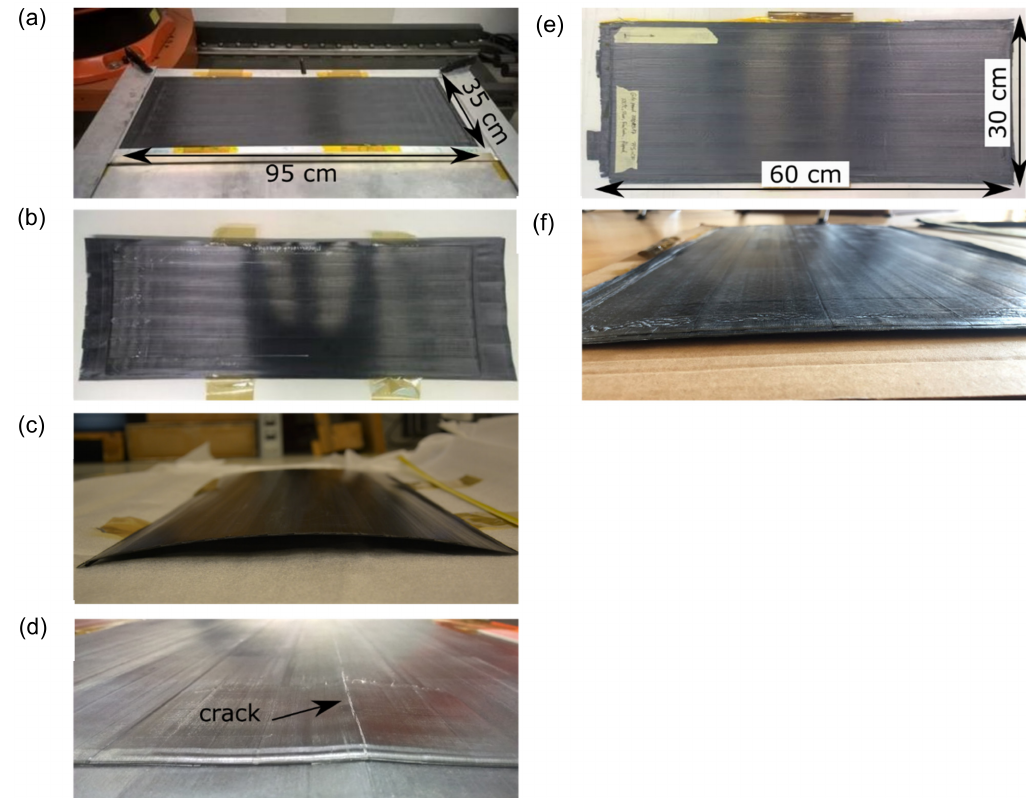
Figure 4. The laminates produced by the clamping method: ( a ) Fixed on the table, ( b ) top, and ( c ) side views after removing the frame, and ( d ) a closer view on the crack due to residual stresses in c-5-330 and the flipping method: ( e ) Top and ( f ) side views.